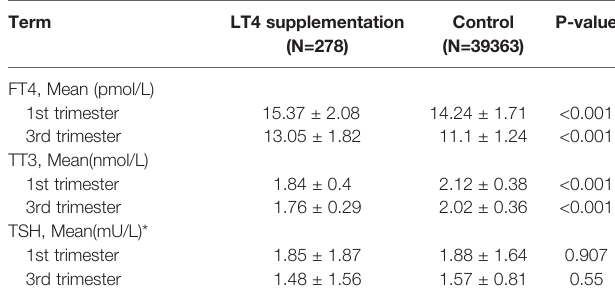
TABLE 2 | Differences in indices of maternal thyroid function between LT4 supplementation group and control group.